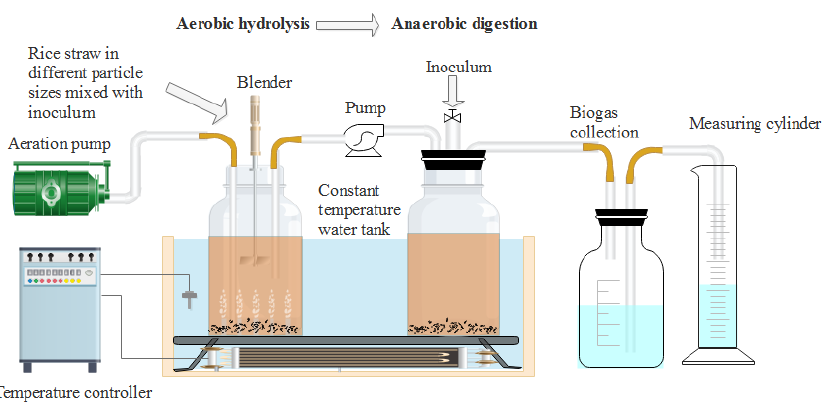
Figure 1. Schematic diagram of the experimental device used in this study.